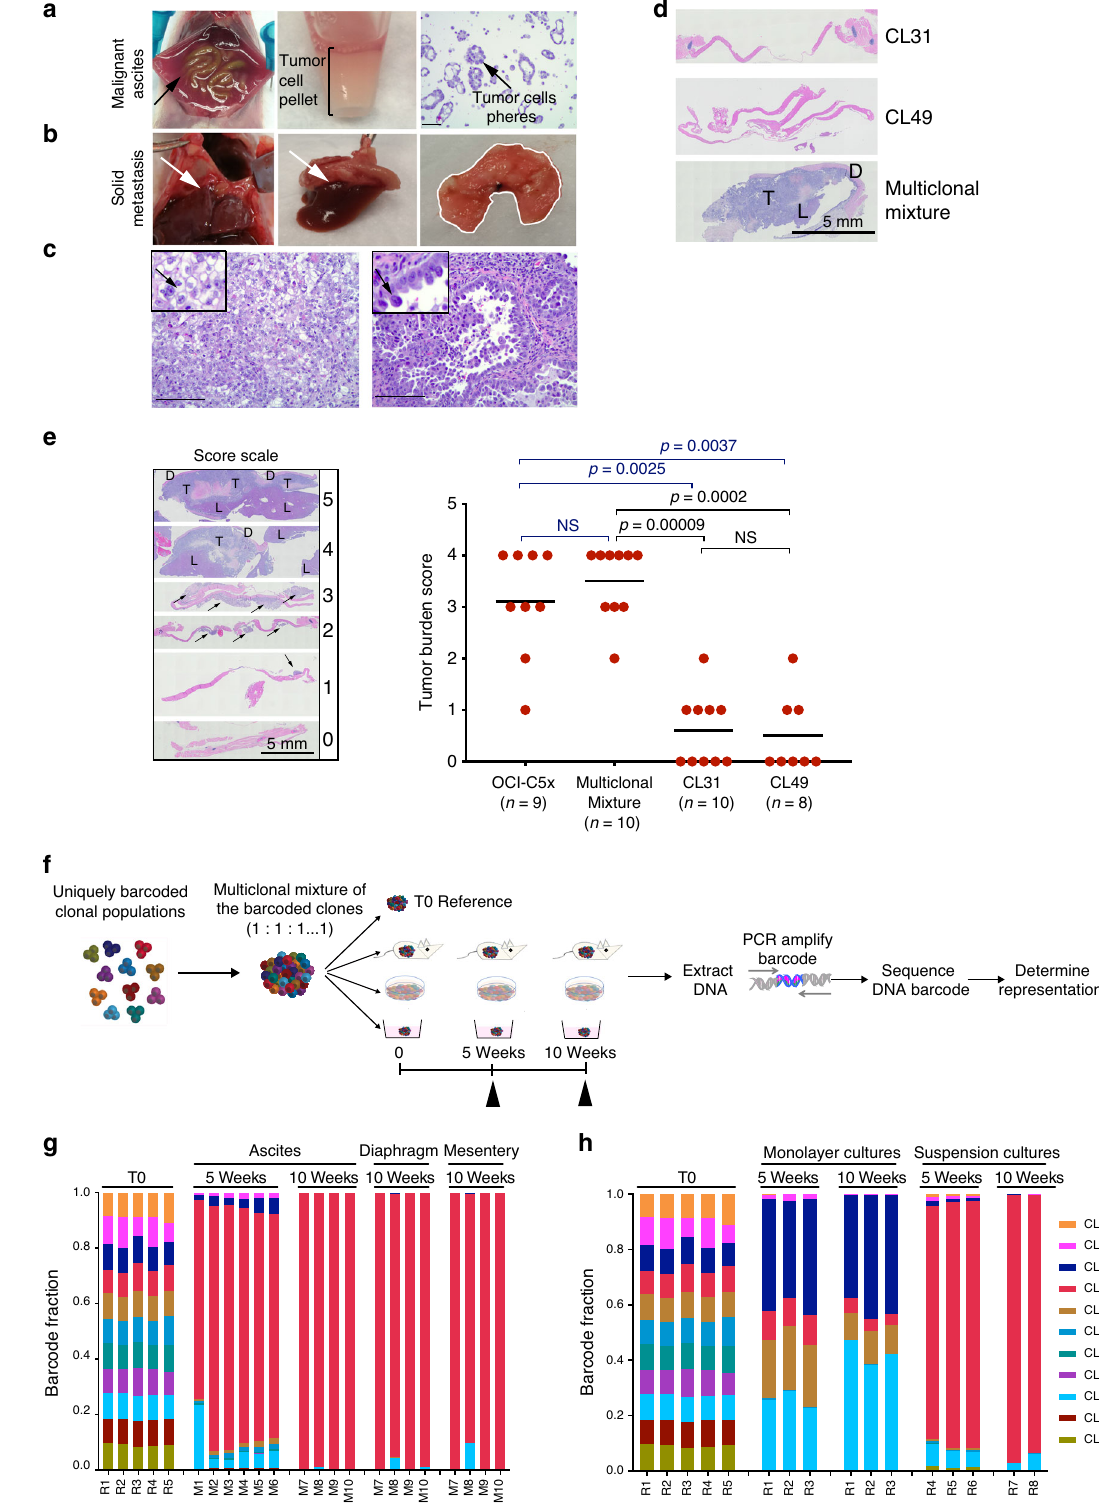
chromosome 17 (centromere CEP17) ratio of two or more with an overall average ratio of 2.54 (Fig. 3b). To test whether ERBB2 ampli fi cation pre-existed in the original patient sample from which OCI-C5x was derived, we performed FISH analysis on histology section of the original primary tumor (ovary primary site). The sample was scored twice by two